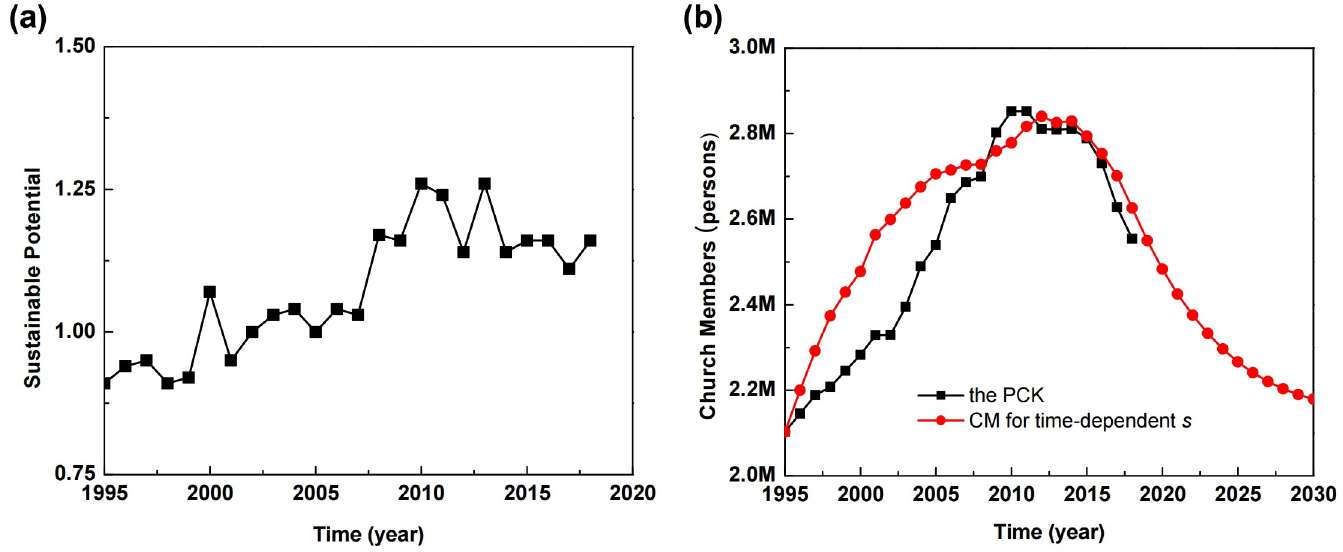
Fig 7. (a) The time-dependent sustainable potential from sustainability measurements (S7 Fig). (b) Simulated church members for time-dependent sustainable potential (red solid circles), and the church population of the PCK (solid squares) (S8 Fig).